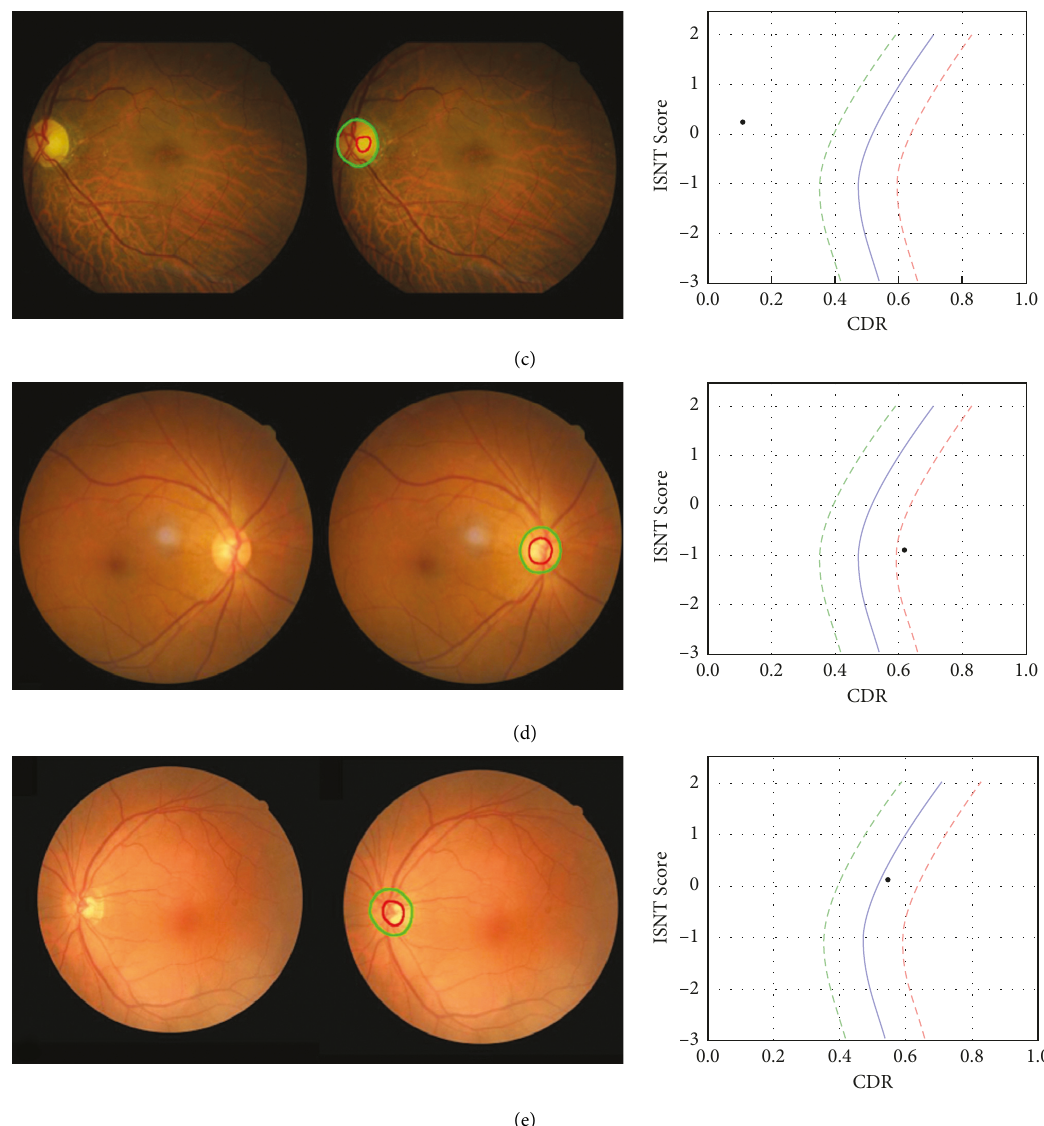
Figure 1: (a) A normal person: AI and four doctors all diagnosed correctly. (b) A patient with advanced glaucoma: AI and four doctors diagnosed correctly. (c) A normal person: AI diagnosis is correct, but the four doctors’ diagnosis was wrong. The reason for the wrong diagnosis is the curved blood vessels under the optic disc, and AI can help doctors correct the diagnosis. (d) A normal person: the AI diagnosis is wrong. The four doctors are not affected by the AI diagnosis, and the diagnosis is correct. The reason for AI diagnosis error may be that the image resolution is slightly low, and the doctor can correct AI diagnosis in this instance. (e) An early glaucoma patient: both AI and a doctor correctly diagnosed. The other three doctors were all wrong. Then, AI can correct the doctor’s